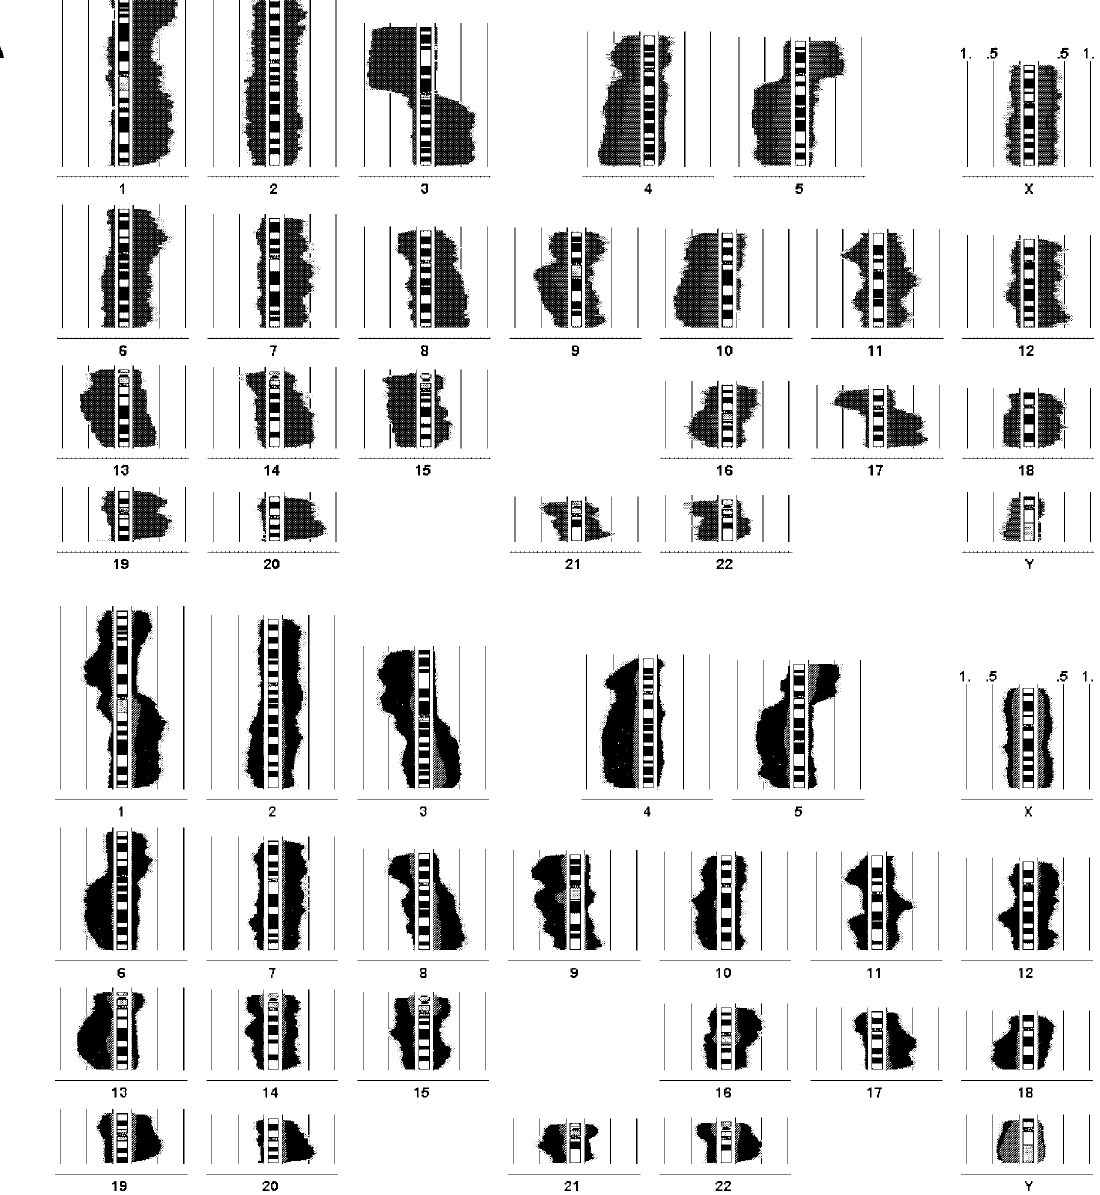
Fig. 1. Histogram of SCLC (A) and NSCLC (B). The chromosomal imbalances are shown as incidence curves along each chromosome. Areas on the left side of the chromosome ideogram correspond to loss of genetic material, those on the right side to DNA gains. The frequency of the alterations can be determined from the 50% and 100% incidence lines depicted parallel to the chromosome ideograms. DNA changes with 99% significance are colored in black, additional changes with 95% significance are depicted in light gray. The proportion of pronounced DNA imbalances are visualised in dark gray (areas close to the 0% incidence line). They are most likely to represent high copy amplifications or multi copy deletions. (C) Difference histogram of SCLC and NSCLC. Green, percentage of changes that are exclusively present in NSCLC. Dark gray, excess of changes in SCLC. White areas beneath the colored parts of each histogram, percentage of changes that are present in both tumour-subgroups. Grey horizontal lines, statistically significant differences. Light grey lines, regions with 95% significance; dark grey lines, 99% significance according to the χ 2